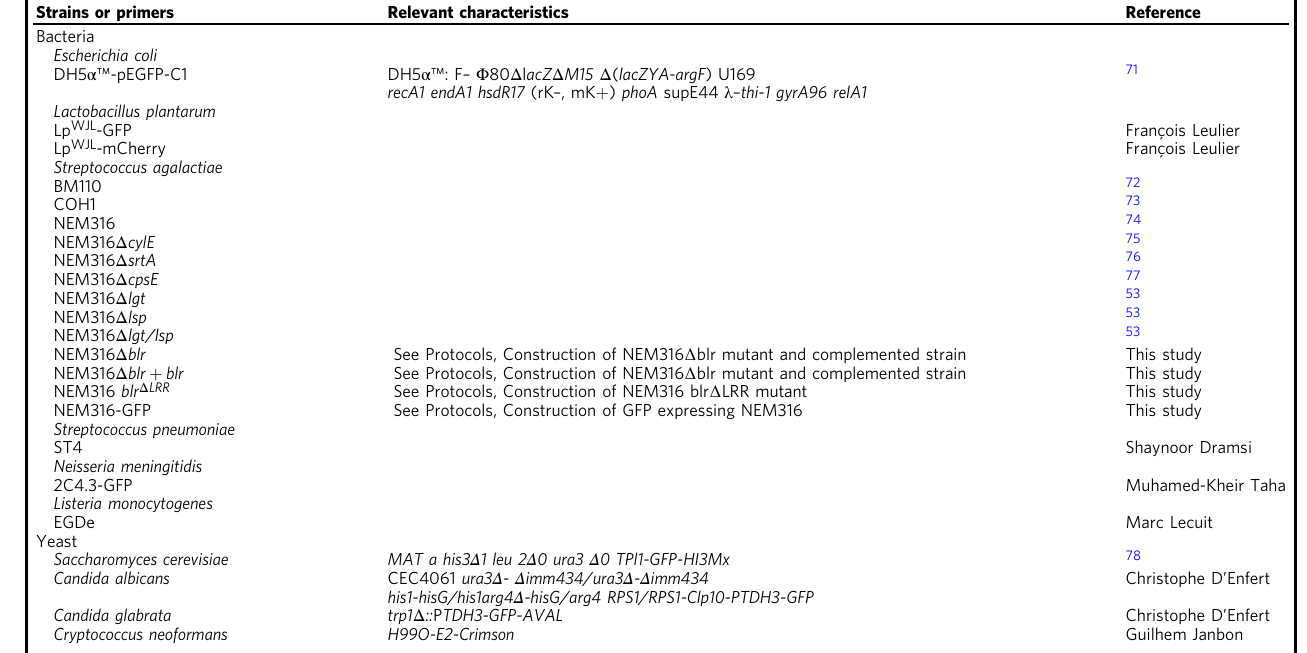
Table 1 Microorganisms and PCR primers used in this